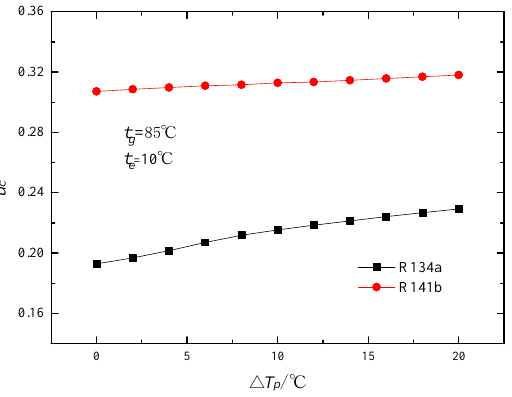
Figure 11. Entrainment ratio versus the primary superheating (cid:52) T p